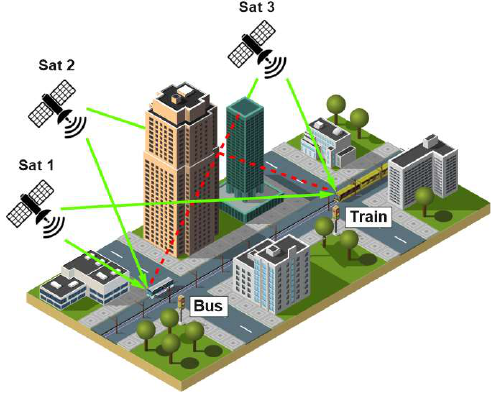
Figure 2. Global Navigation Satellite System (GNSS) signal obscuration in urban area.